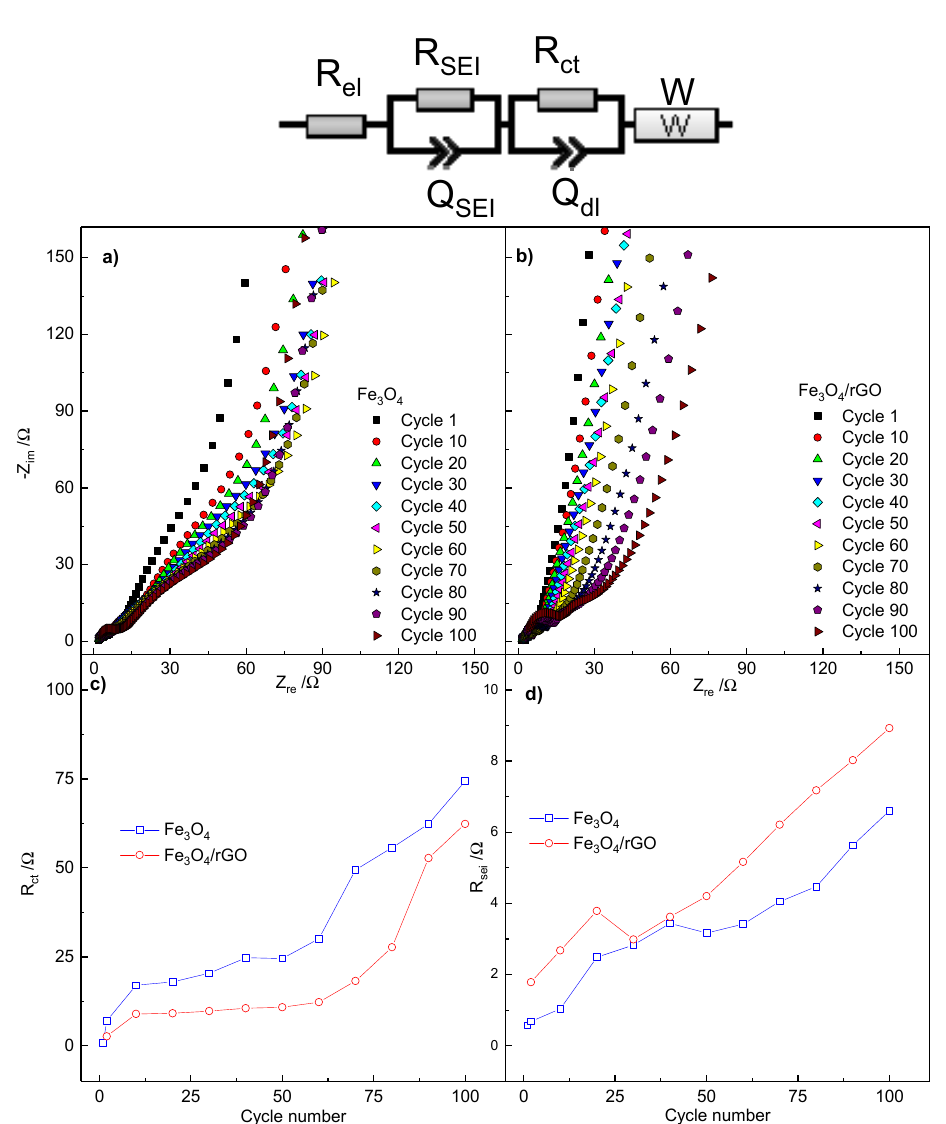
Figure 8. ( a ) Nyquist plot of Fe 3 O 4 nps acquired every 10 cycles, ( b ) Nyquist plot of Fe 3 O 4 /rGO acquired every 10 cycles. ( c ) Evolution R SEI for both materials upon cycling and ( d ) evolution of R ct upon cycling. The PEIS measurement were conducted in the frequency range of 101 KHz < f < 9 mHz at 0.75 V in the first cycle and at 0.9 V for the further ones, with a sinusoidal perturbation of 5 mV.